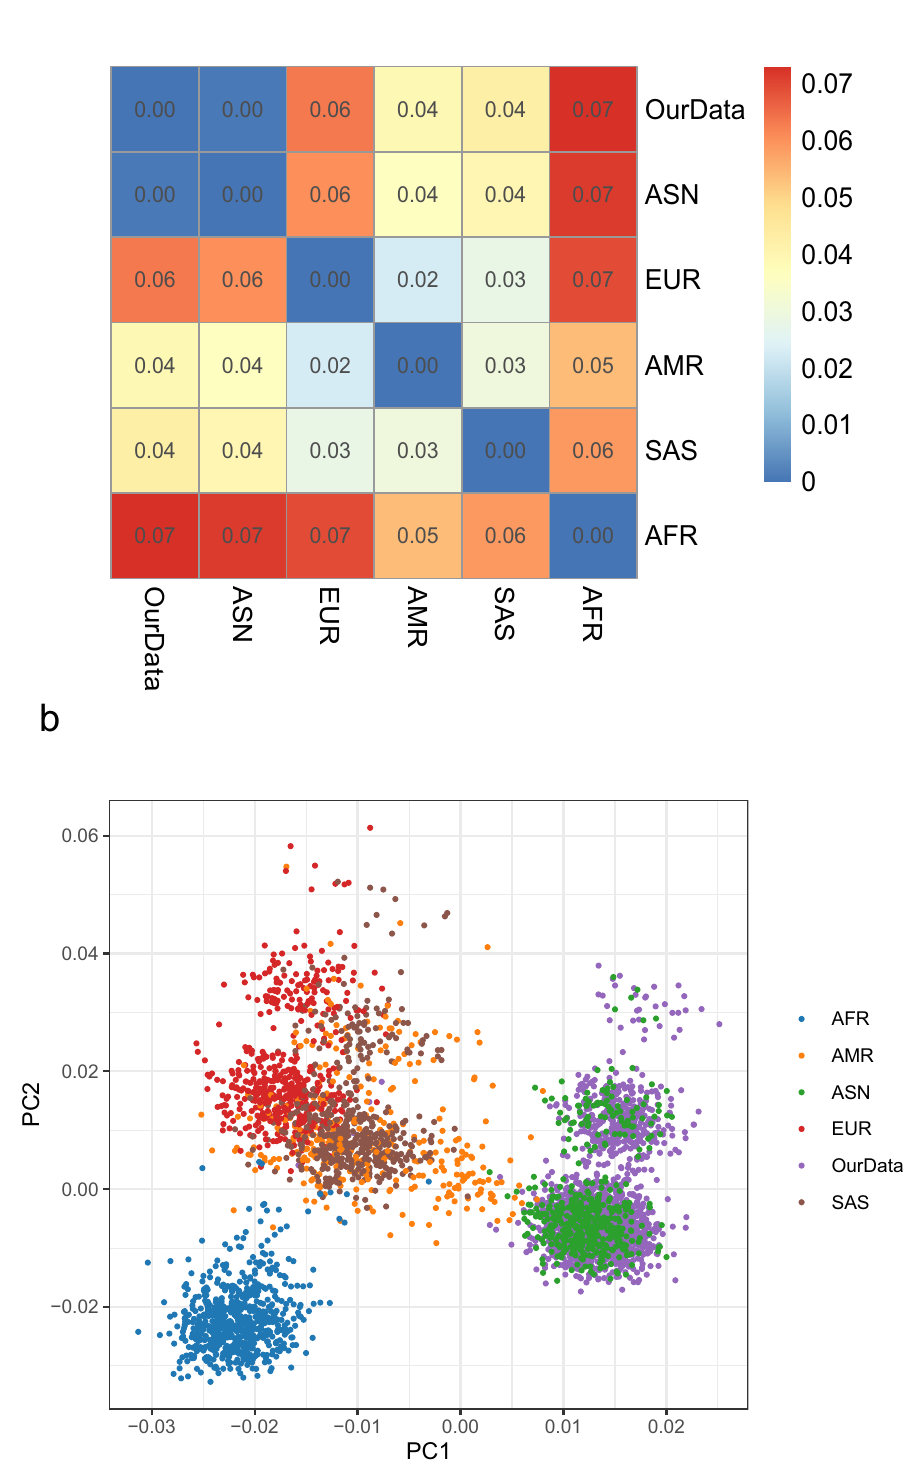
Fig. 2 Genetic architecture of 1794 lung cancer patients. a Pairwise Fst difference between the Chinese lung cancer cohort and other populations. b Principal component analysis (PCA) of Chinese Lung cancer patients and other populations in 1000 genome project. AFR African. AMR Admixed American. ASN East Asian. EUR European. SAS South